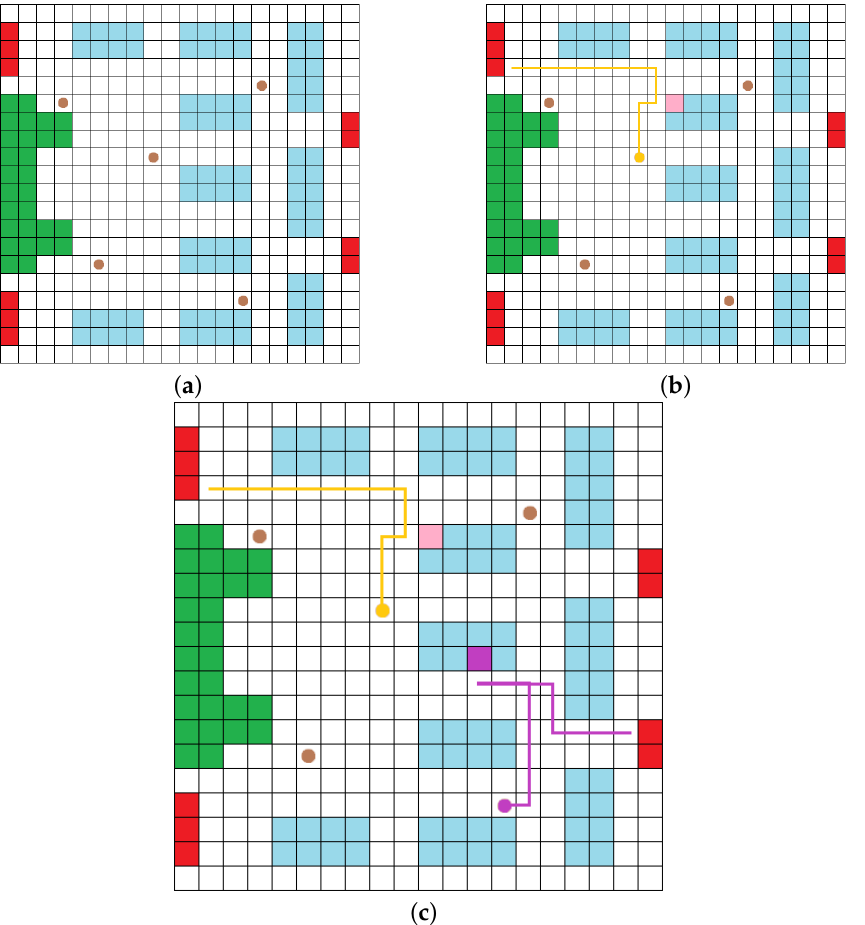
Figure 7. In this example, we see a 20 × 20 warehouse environment, with 4 exits and 5 robots. ( a ) Initial positions and the environment topology. ( b ) The task allocated to the first robot, on the top left exit. ( c ) The task allocation of the second robot, including the first robot. The algorithm decides to deliver the products on different exits since it is more